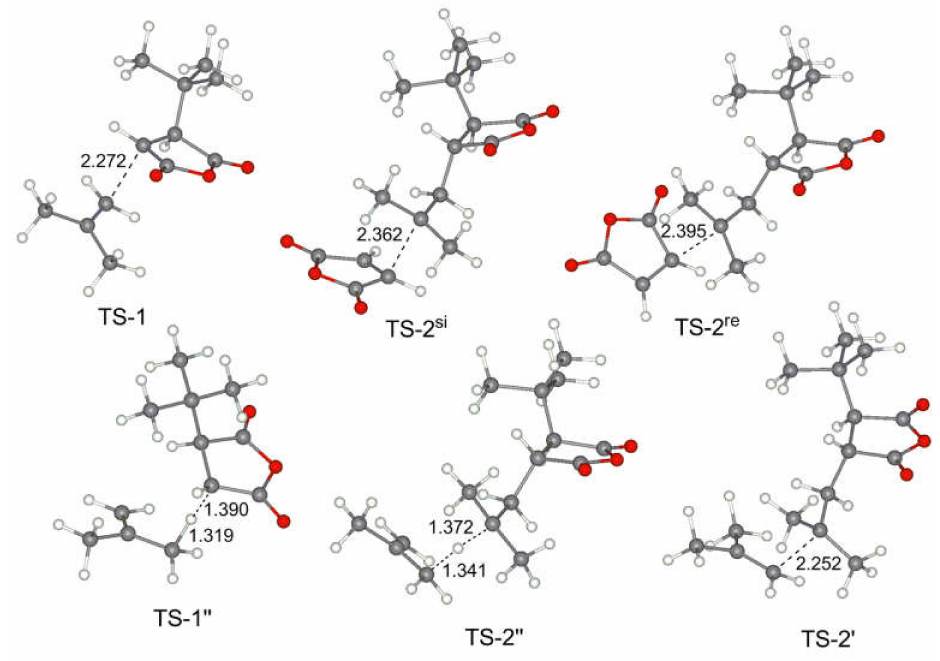
Figure 5. Calculated geometries of the key transition states for MA–IB copolymerization.